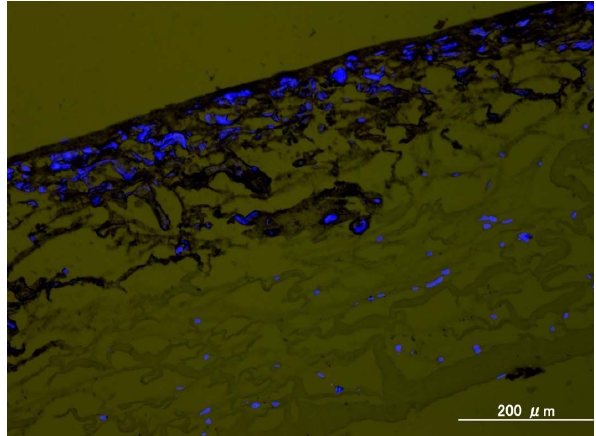
Figure 6 A fluorescence microscopic picture of a DAPI-stained, cross-sectioned construct with a calcified upper region. The majority of the blue-stained cells are in the upper